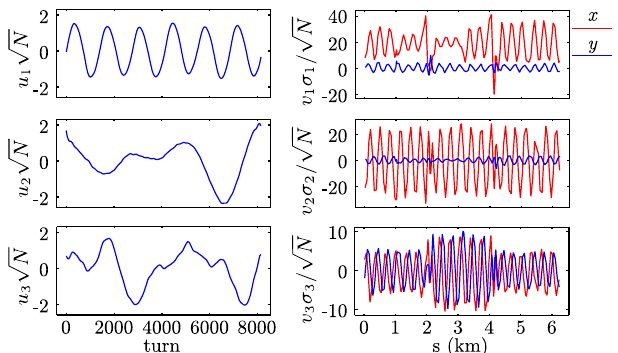
FIG. 9. Slow MIA modes. Low-pass Fourier filter ( f < 0 : 004 ) was applied to BPM readings prior to